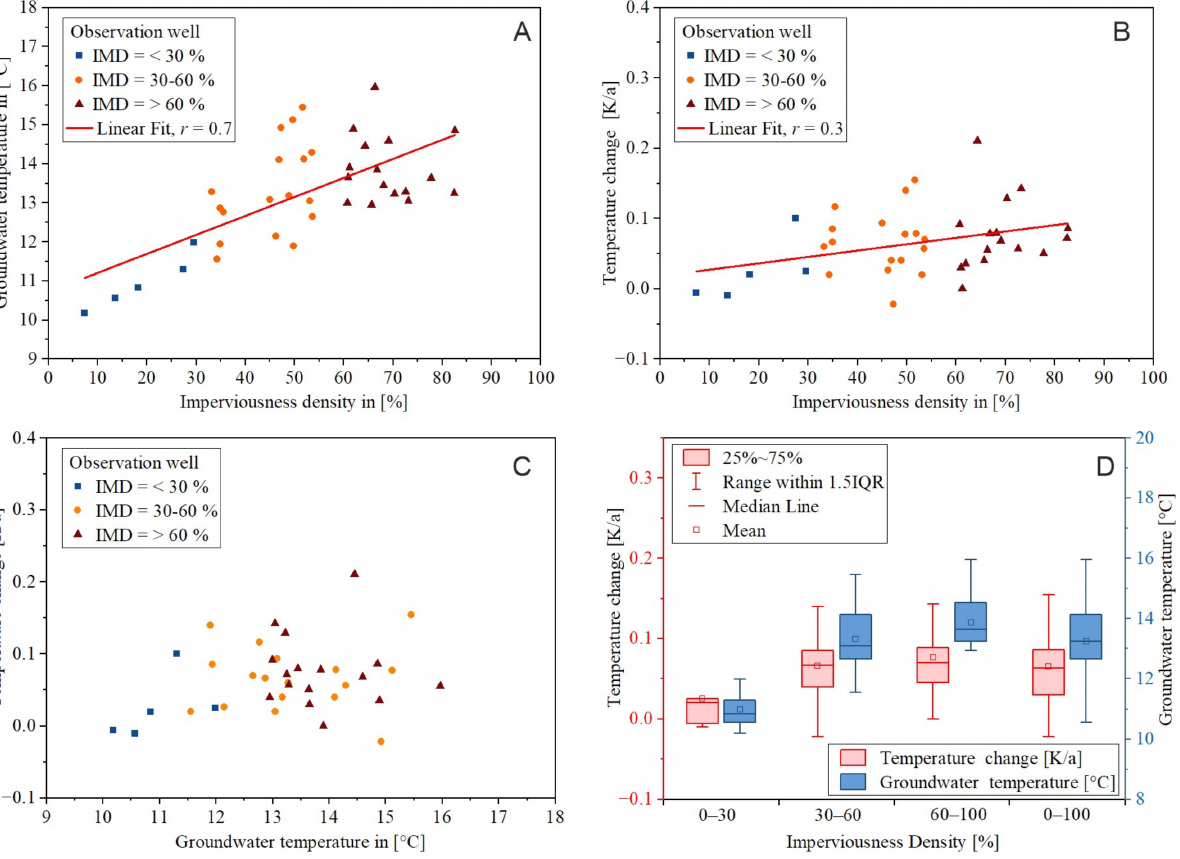
Figure 7. ( A , B ): Plots of IMD r = 500, against groundwater temperature and temperature change. The linear trends are clearly visible. Plot ( C ): temperature changes against groundwater temperature. There is only a very weak positive correlation between the individual values. Plot ( D ): statistical evaluation of GWT and groundwater shift for different urban settings, derived from the degree of sealing IMD r =